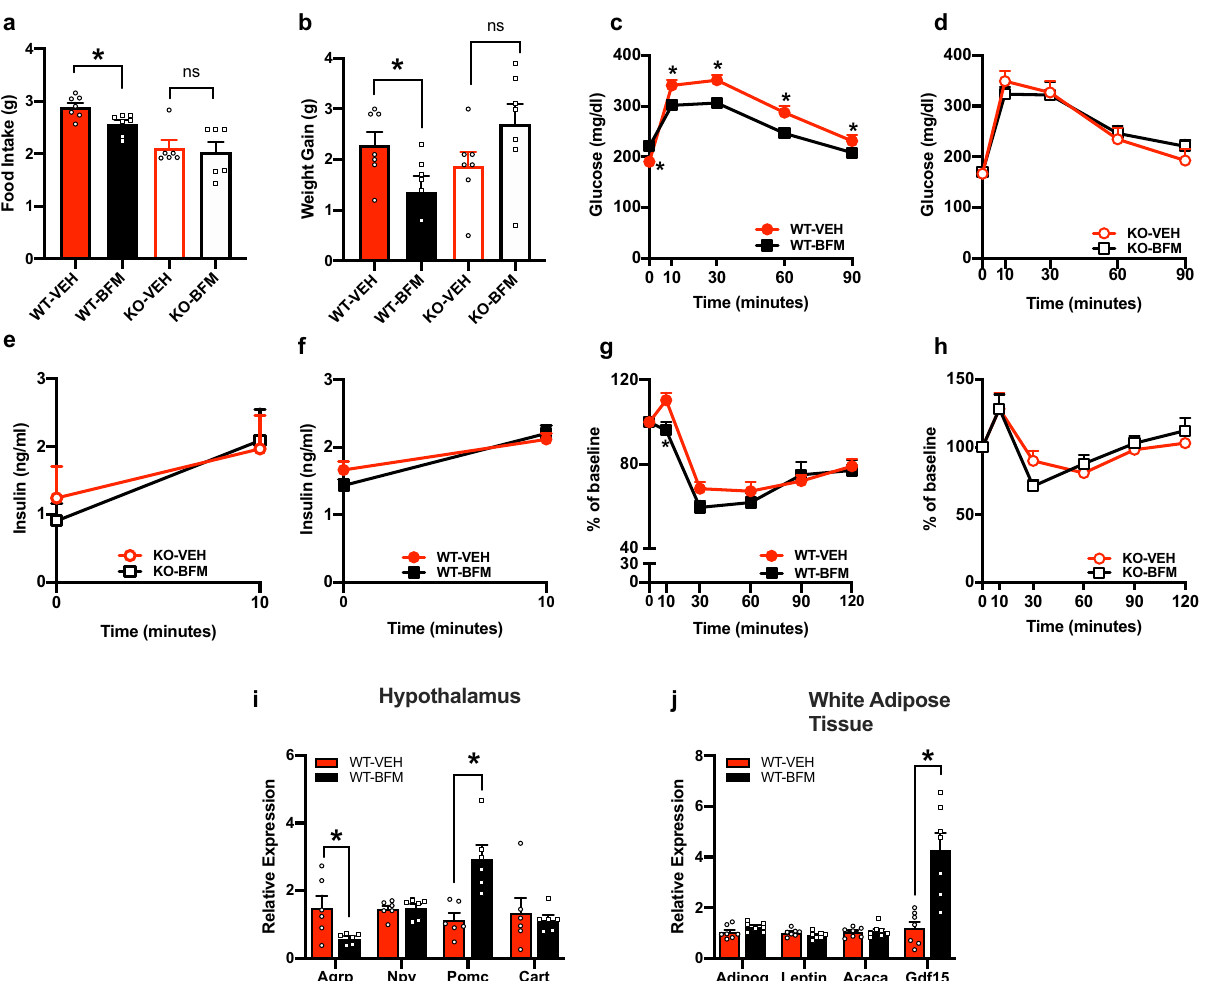
Fig. 6 | Inhibition of V-ATPase abrogates HFD-induced weight gain which is dependentontheadipocyteexpressionofAtp6v0a1.a Averagedailyfoodintake ( F =10.21, df=3, p <0.001), (WT-VEH n =7, WT-BFM n =7, KO- VEH n =6, KO-BFM n =6). b weightgaininWT(solidbars)andKO(openbars)miceafter7daystreated withBFM(black)orVEH(red)andfedHFD( F =3.27,df=3, p =0.03),(WT-VEH n =7, WT-BFM n =7, KO-VEH n =6, KO-BFM n =6). c , d GTT after 3days of treatment (group: F =1.19, df=3, p =0.33; time: F =206, df=4, p <0.001; genotype X time: F =4.48, df=12, p <0.001), (WT-VEH n =8, WT-BFM n =8, KO-VEH n =7, KO-BFM n =8), e , f Glucose stimulated insulin secretion, (group: F =0.35, df=3, p =0.78; time: F =38.62,df=1, p <0.001;genotypeXtime: F =1.46,df=3, p =0.25),(WT-VEH n =8, WT-BFM n =8, KO-VEH n =7, KO-BFM n =8). g , h ITT after 7days treatment with BFM (WT-VEH n =8, WT-BFM n =7, KO-VEH n =8, KO-BFM n =7: F =8.02,